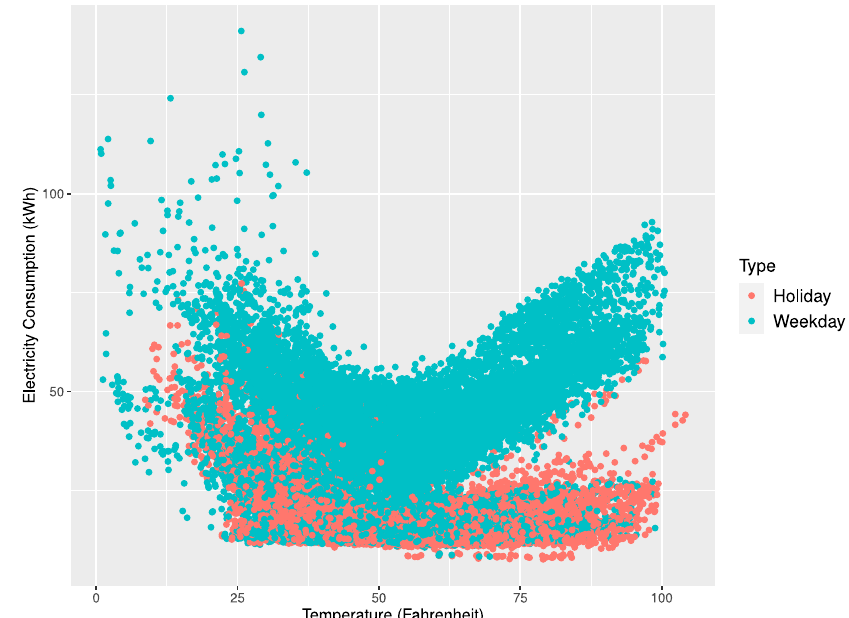
Figure 4. Scatter plot of electricity consumption and temperature for Building 1.